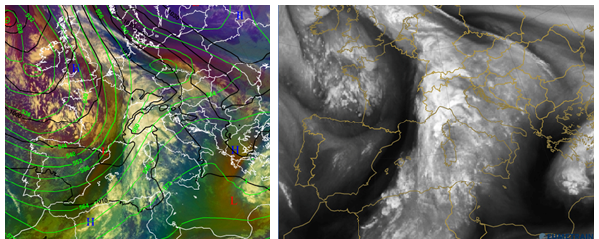
Figure 4. 25 October 2011, 12:00UTC: (left) air mass RGB EU- METSAT product from MSG SEVIRI, mean sea level pressure (black contour lines) and geopotential height at 500hPa (green con- tour lines) from ECMWF analysis and (right) MSG water vapor image at 6.2µm (EUMeTrain,